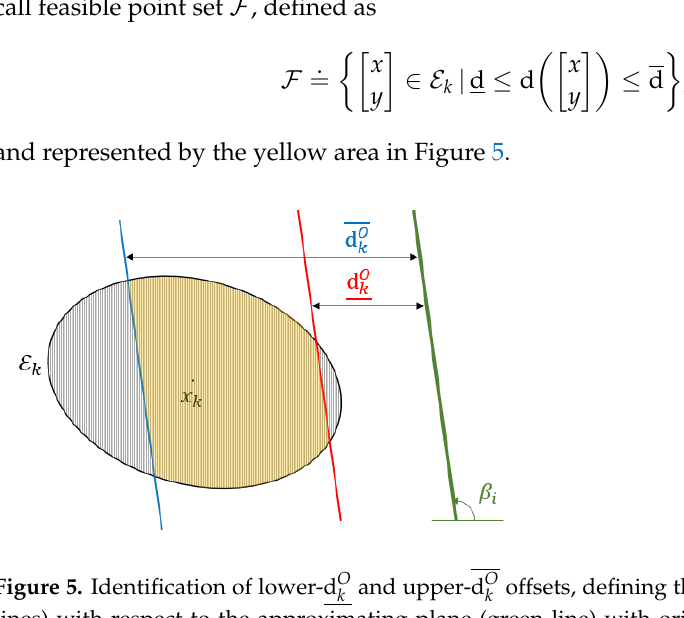
The parallel-cuts ellipsoid method, described in [40], allows the simultaneously use of the constraints imposed by the pair of parallel cuts to generate the new ellipsoid E having minimum volume and containing all the points between the two half-spaces